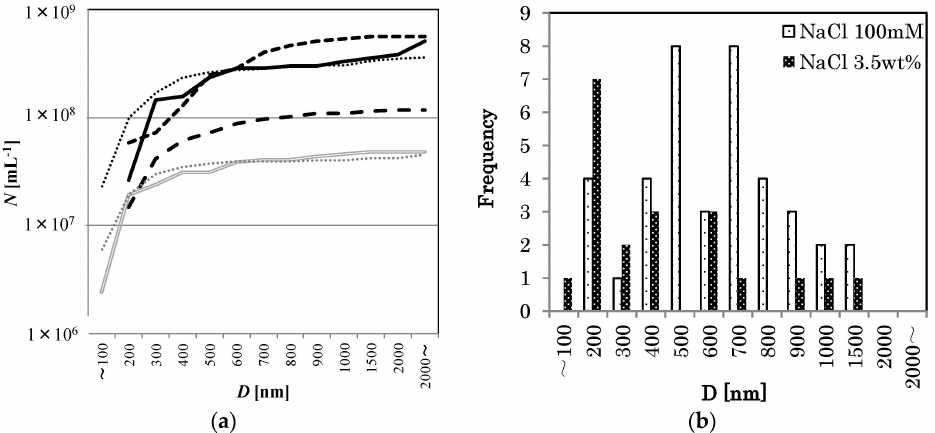
Figure 3. ( a ) The cumulative distributions of D in different NaCl concentrations (0 mM: Solid line, 10 mM: larger dashed line, 100 mM: Smaller dashed line, 1 wt %: Dotted line, 3.5 wt %: Double solid line, pure water: thin dotted line). The value at the largest D equals the number density N . ( b ) Apparent bubble diameter distributions in 100 mM NaCl solution (coarse dot bar, n = 39), and in 3.5 wt % NaCl solution (fine dot bar, n =